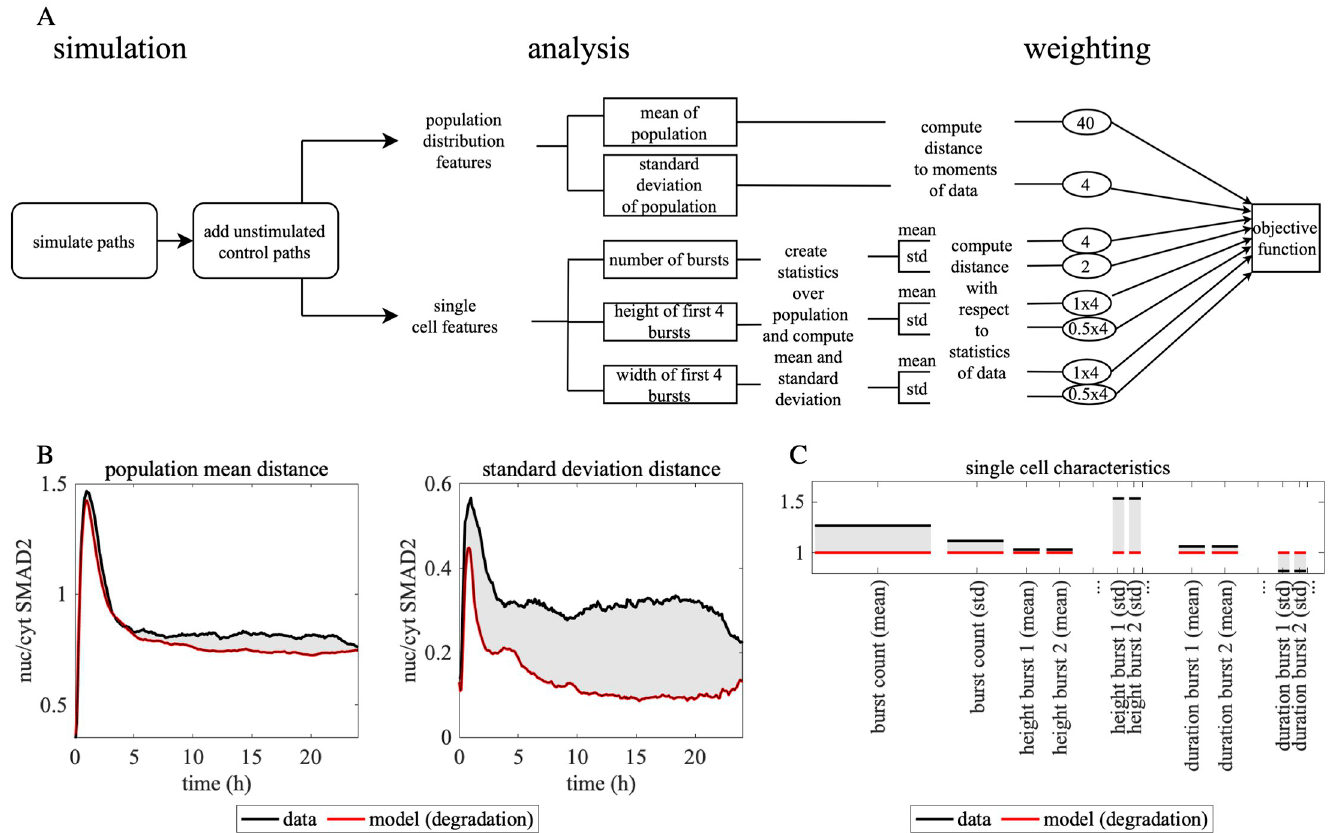
Fig 3. Design of the objective function for the parameter estimation process. A: Flowchart describing the computation of the objective function for parameter estimation. Starting from simulating the nuc/cyt SMAD2 ratio in many single cells, to which technical noise in the absence of stimulation was added, the deviation from an experimental data set is computed: The characteristics of both population summary statistics (mean and standard deviation of nuc/cyt SMAD2 snapshots over all time points) and individual cells (number of bursts, height and width of the first bursts) are included in the objective function. The differences between data and simulation with respect to the individual components are scaled for comparability and added up with their corresponding weight to obtain a scalar value of the objective function. See Methods for details. B: Calculation of snapshot mean and standard deviation as components of the objective function. The population mean (left) and standard deviation (right) over time of the nuc/cyt SMAD2 ratio is shown for an experimental data set and a simulation using the degradation model. The gray area between the trajectories reflects the corresponding objective function component. C: Bar chart of selected burst related objective function components. The bar chart shows the statistics (mean and standard deviation) for the distributions of the single cell properties which are taken into account in the objective function: number of bursts, height and duration of the first four bursts. The statistics of the data are shown in black and those of the simulation in red. The gray area in between corresponds to the weighted component of the statistics as taken into account in the objective function. The width of the bars reflects the weighting